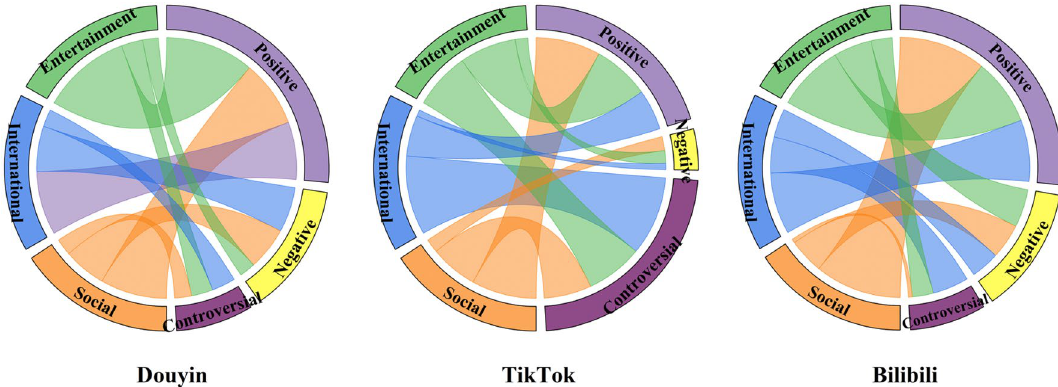
Figure 4. Chord diagram representation of platform dimension and topic dimension colored by sentiment. The three colors in the left semicircle indicate the three topics, and the three colors in the right semicircle indicate the set of positive, controversial, and negative EC types. The arc length indicates the percentage of ECs belonging to that type. The inner colored connecting bands indicate the flow and direction of the data relationships.